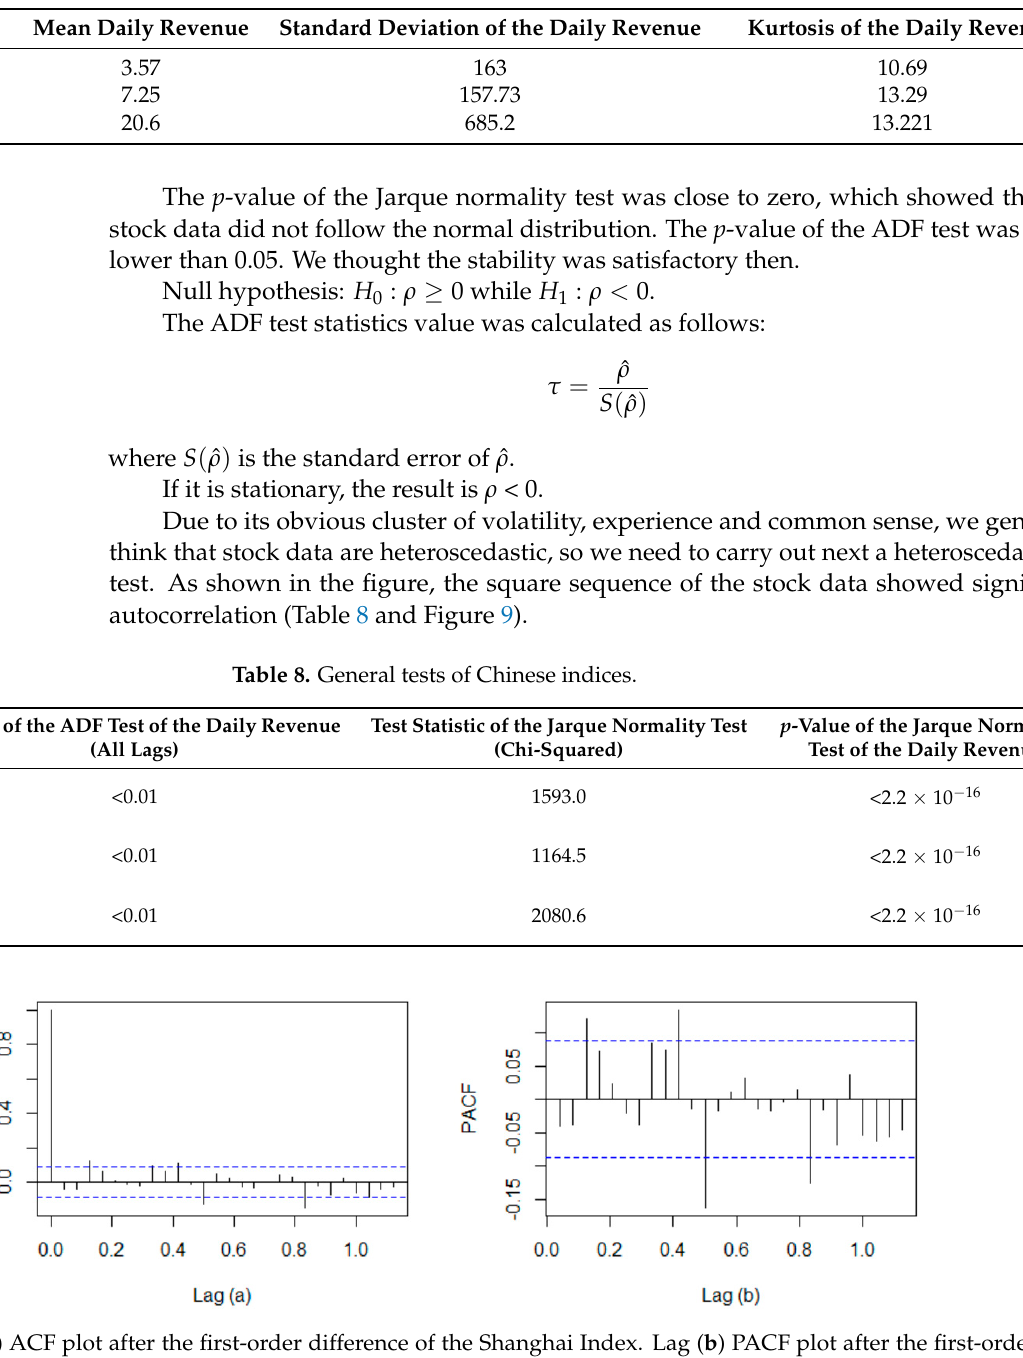
Table 7. General statistics of Chinese indices.